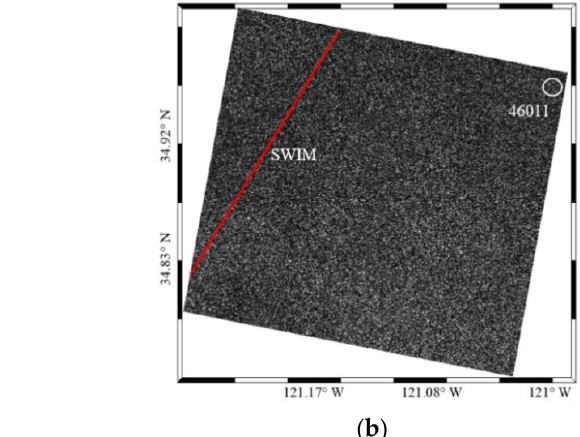
Figure 1. Data matching: ( a ) Distribution of matched data (S-1 SAR WV and CFOSAT SWIM) over a revisit period. ( b ) Position of Buoy 46011 and SWIM in SAR image.